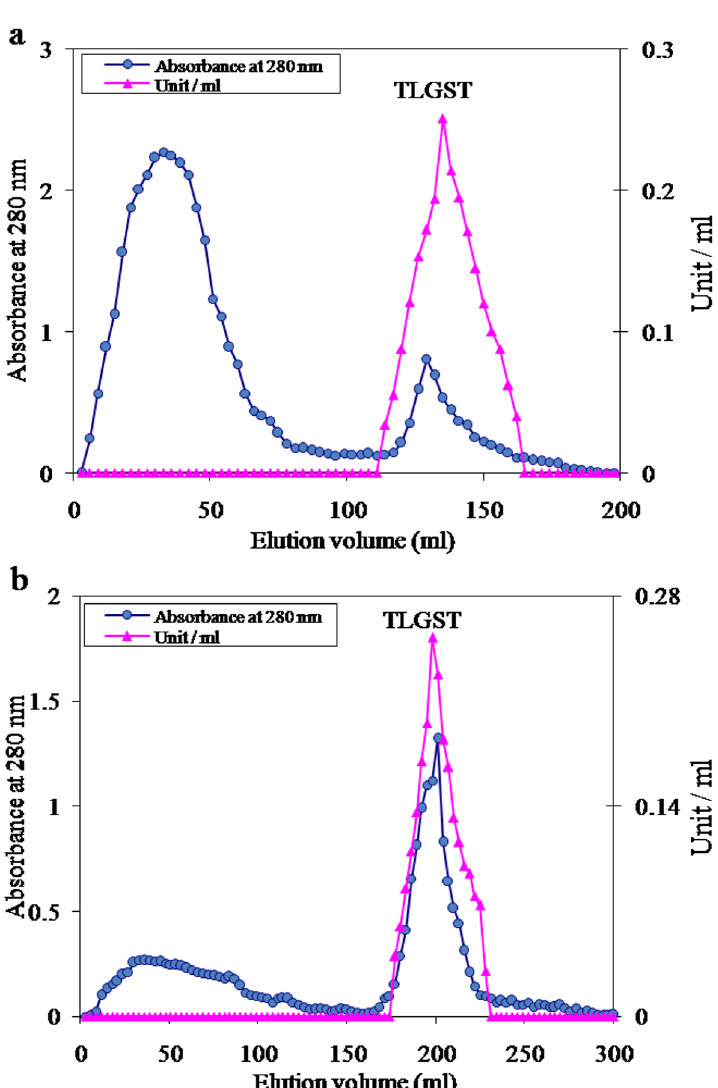
Fig. 1 a The chromatographic pattern of 40–80% ammonium sulfate fraction of tick larvae crude extract on GSH-Sepharose column (8 previously equilibrated and washed with 0.02 M Na-phosphate buffer pH 7.0. b The chromatography of tick larvae TLGST on Sephacryl S-300 column (142 cm 2.4 cm) formerly equilibrated with 0.02 M Na-phosphate buffer pH ×